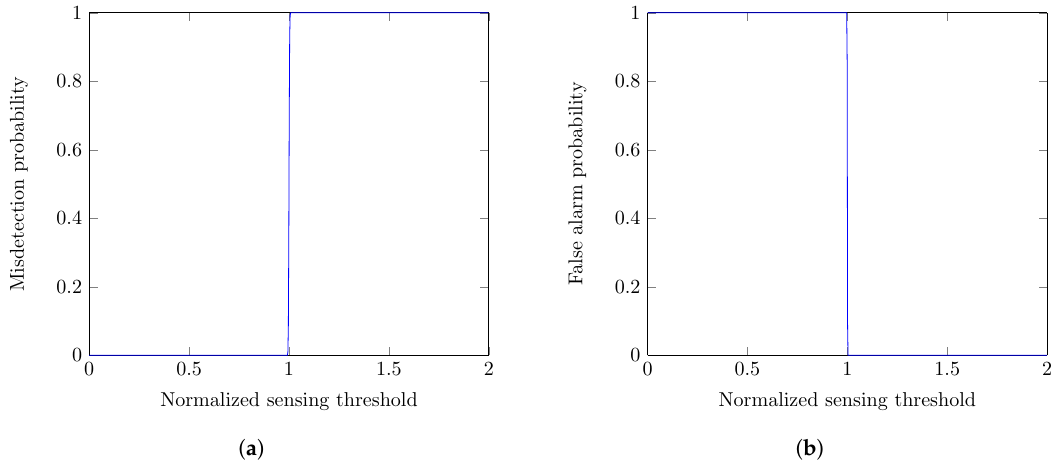
Figure 6. Optimization of normalized sensing threshold (at SNR=0). ( a ) Misdetection probability vs. normalized sensing threshold; ( b ) False alarm probability vs. normalized sensing